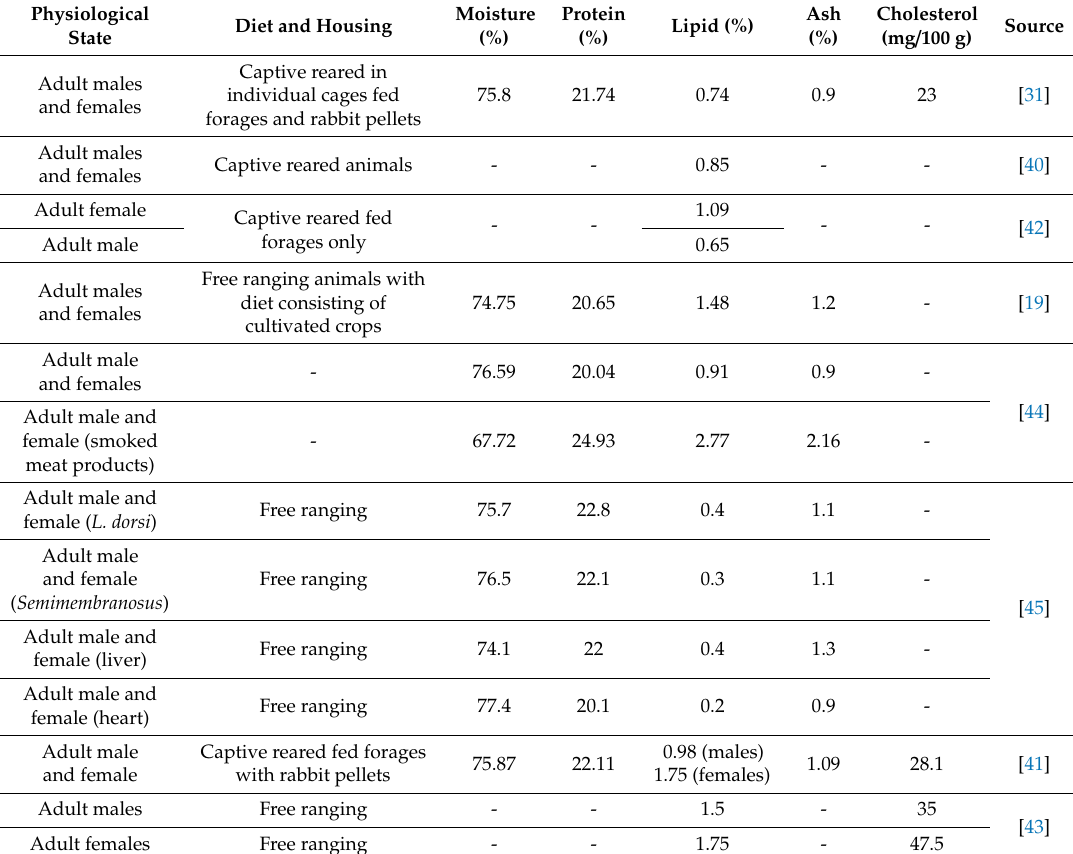
Table 1. Proximate analysis of the meat products and edible o ff al of capybara ( H. hydrochaeris